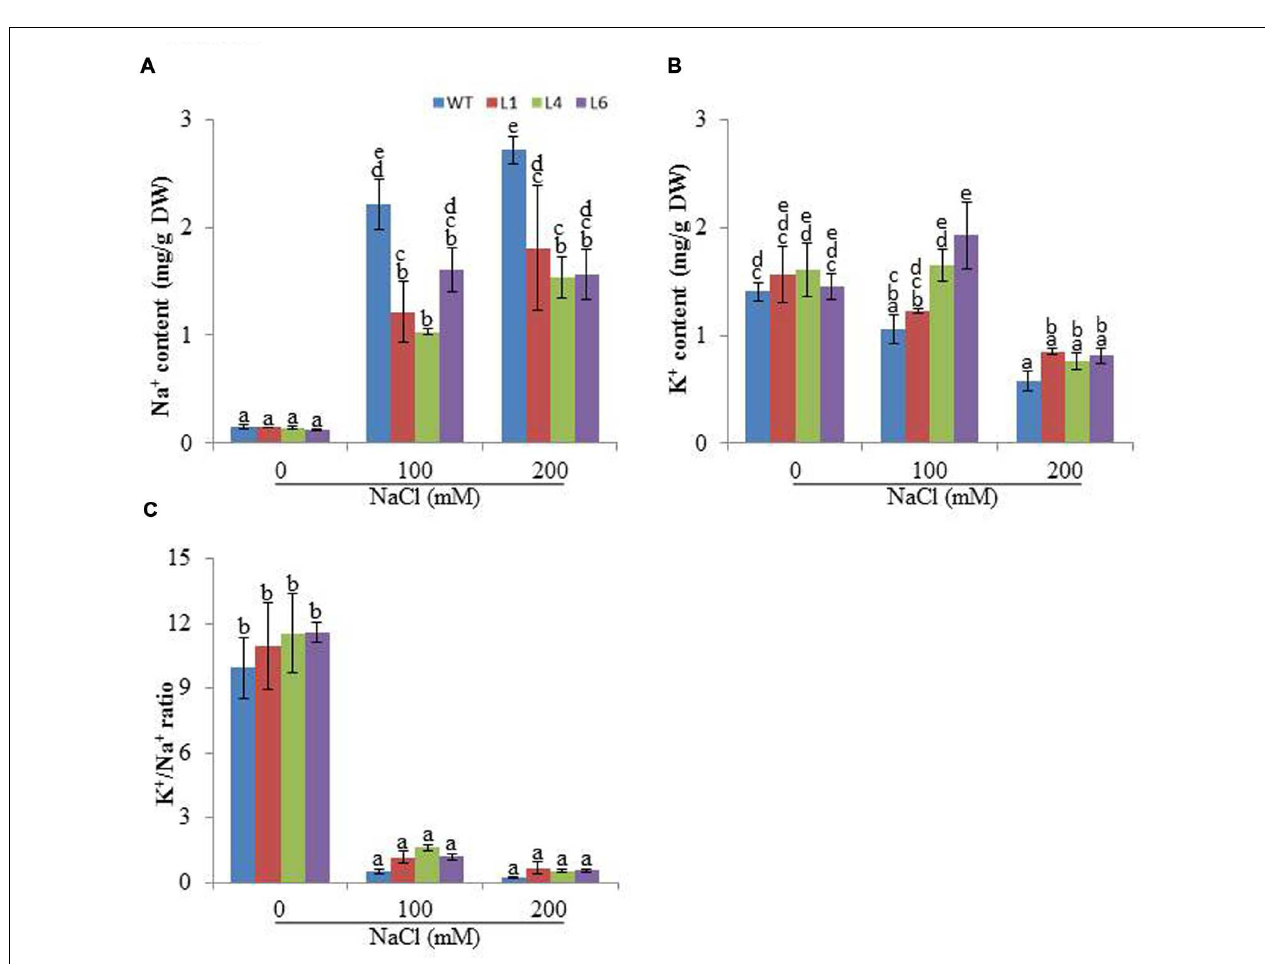
FIGURE 6 | Analysis of ion content in leaves of WT and JcPR-10a transgenic tobacco plants grown at 0, 100, and 200 mM NaCl, (A) Na + content, (B) K + content, (C) K + /Na + . Values are represented as means ± SE ( n = 3) and marked with different alphabets to indicate significant difference at P ≤ 0.05